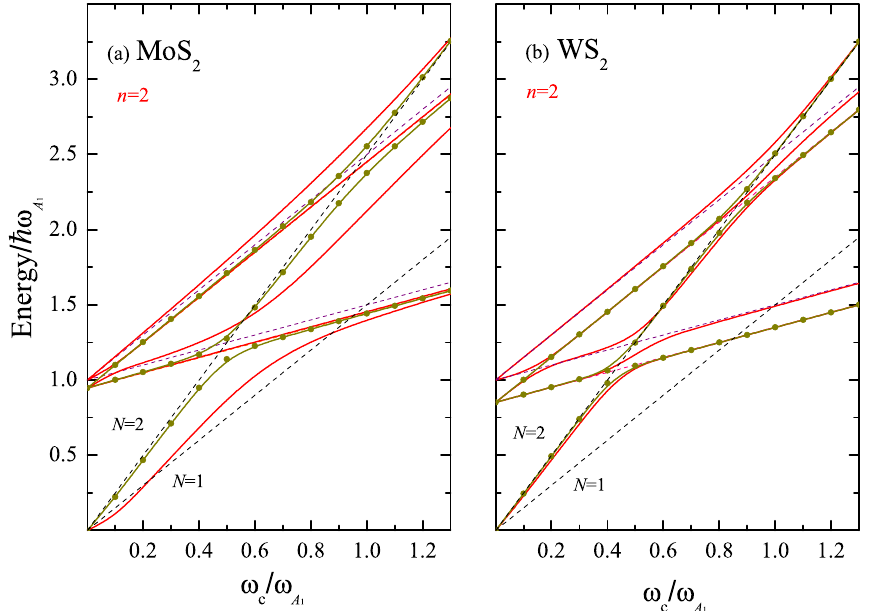
Figure 2. The total MP energies, ˆ ǫ n / (cid:31) ω A 1 , for n = 2 (red lines) vs the reduced cyclotron frequency ω c /ω A 1 for ( a ) MoS 2 and ( b ) WS 2 . The contribution of the PF interaction is indicated by olive circles+solid line . The black dashed lines represent the bare Landau energy (cid:31) ω c ( N + 1 / 2 ) , while the orange and violet dashed lines correspond to the bare excited states (cid:31) ω LO + ( p 1 + 1 / 2 ) (cid:31) ω c and (cid:31) ω A 1 + ( p 2 + 1 / 2 ) (cid:31) ω c . Two excitations for p i ( i = 1,2) are